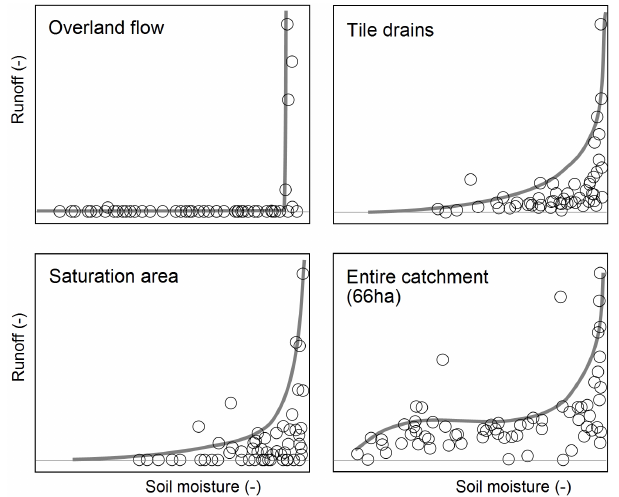
Figure 6. Non-linear runoff generation in the Hydrological Open Air Laboratory (HOAL), Lower Austria. Scaled peak runoff of events plotted against scaled soil moisture at the beginning of these events. Each point represents one event. The panels refer to the flumes shown in Fig. 5, which represent different runoff generation mechanisms. From Vreugdenhil et al.